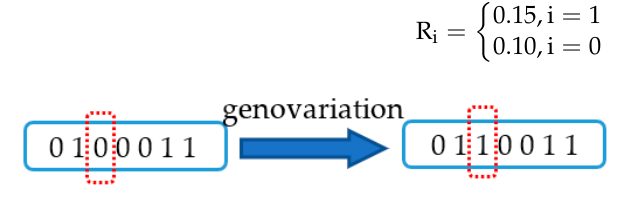
Figure 9. Diagram of variation.